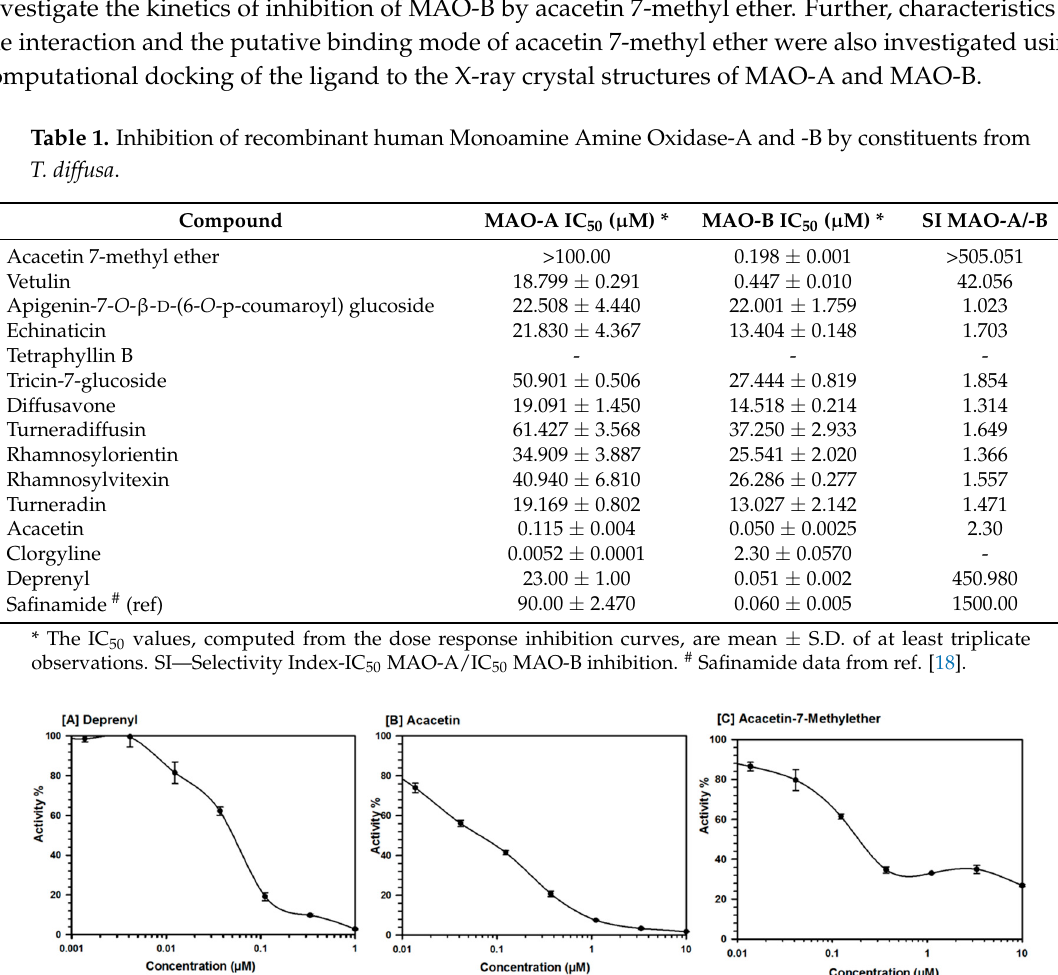
Figure 2. Concentration-dependent inhibition of recombinant human MAO-B by ( A ) deprenyl, ( B ) acacetin, and ( C ) acacetin 7-methyl ether. Each point shows mean ± SD of three observations.